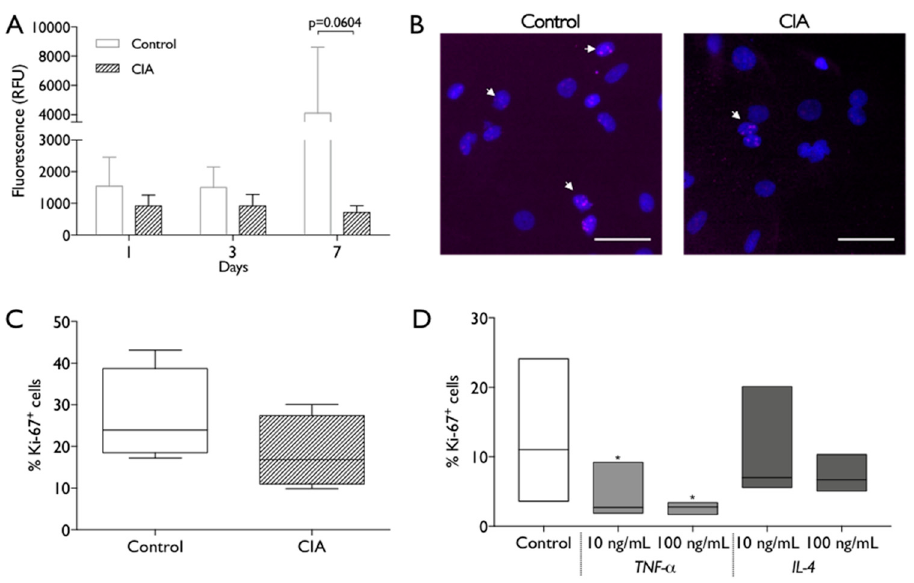
Figure 5. MSC metabolic activity and proliferation capacity. ( A ) Metabolic activity was measured at 1, 3 and 7 days of MSC culture by resazurin assay. RFU: relative fluorescence units. Statistical di ff erences were evaluated by 2-way ANOVA followed by Turkey’s multiple comparison test ( B ) Representative images of nuclei (Dapi, blue) and Ki-67 immunostaining (pink, white arrows) of control and CIA-derived MSC after 2 days in culture. Scale bar: 50 µ m. ( C ). Percentage of Ki-67 + control and CIA-derived MSC, across di ff erent experiments. Statistical di ff erences were evaluated by Mann–Whitney test. ( D ) Percentage of Ki-67 + control- derived MSC after 2 days in absence / presence of 10 ng / mL or 100 ng / mL of TNF- α or IL-4. Box plots represent min-to-max distribution of n = 4 to 5 animals per group. * p < 0.05 by Friedman test followed by Dunn’s multiple comparisons test.